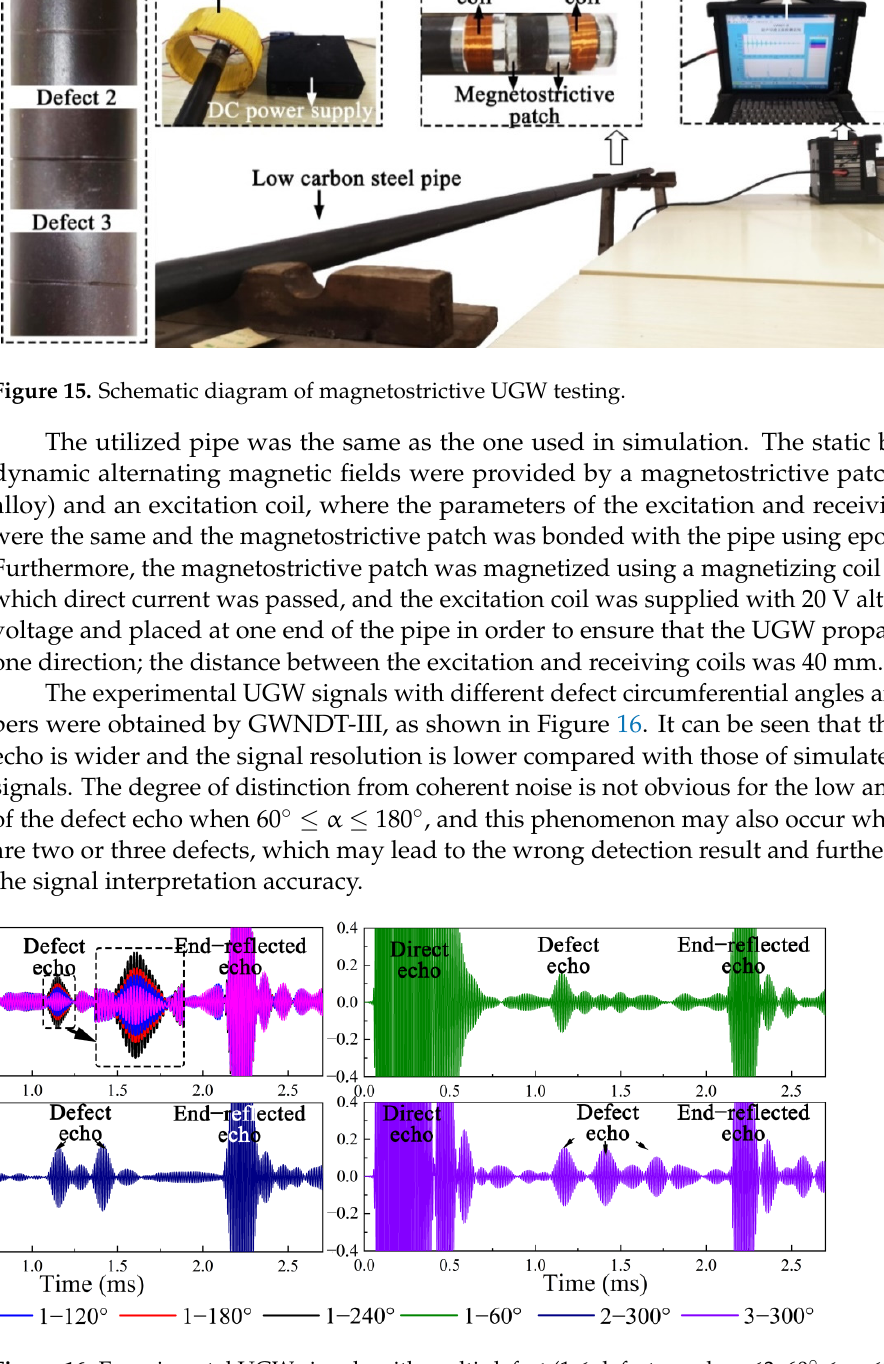
Figure 16. Experimental UGW signals with multi-defect (1 ≤ defect number ≤ 3, 60 ◦ ≤ α ≤ 300 ◦ ). GS-SSP and FBR-RC-SSP were applied to the experimental UGW signals (1–2.5